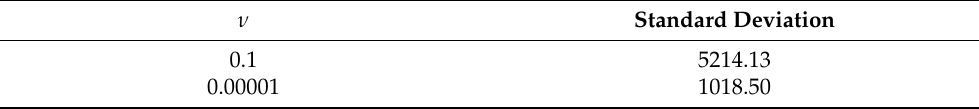
Table 4. The standard deviations of the optimized portfolios obtained with the different values of ν .